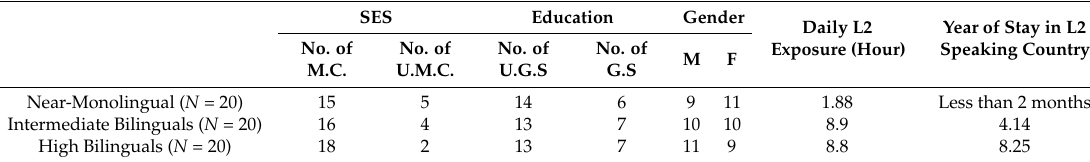
Table 2. The description of